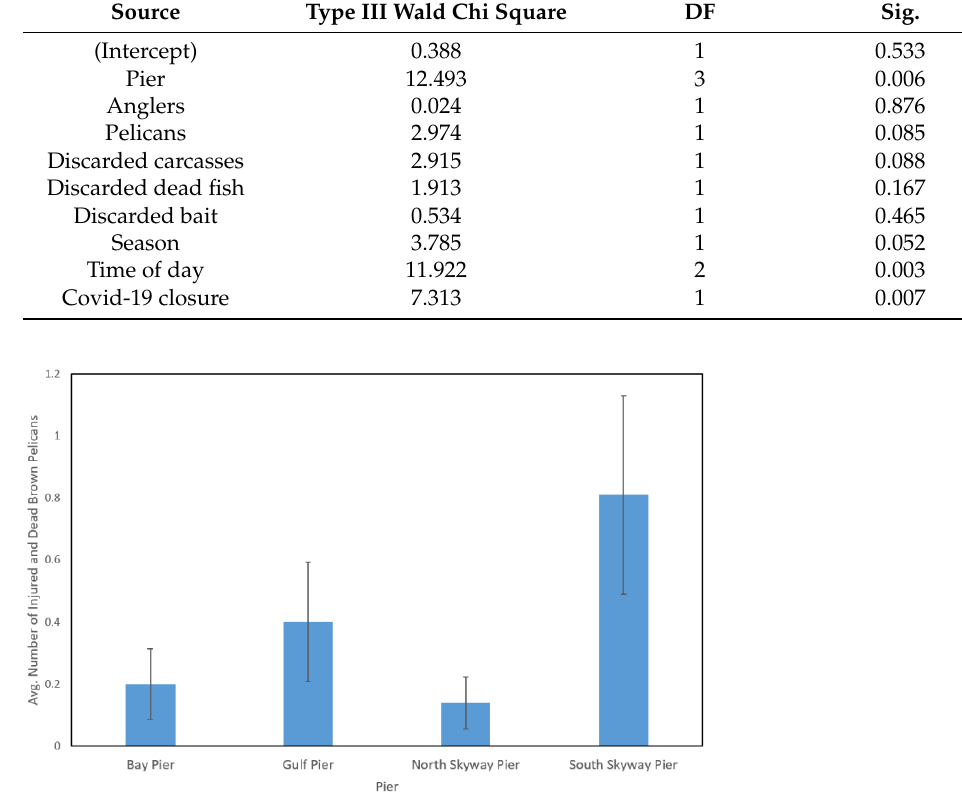
Figure 2. Estimated marginal mean (SE bars) number of injured and dead Brown Pelicans at the four piers for each survey after controlling other variables in the model. The South Skyway and Gulf piers had significantly more injured and dead pelicans than the Bay and North Skyway piers ( p < 0.05, LSD post hoc test). Sample size = 144 surveys.